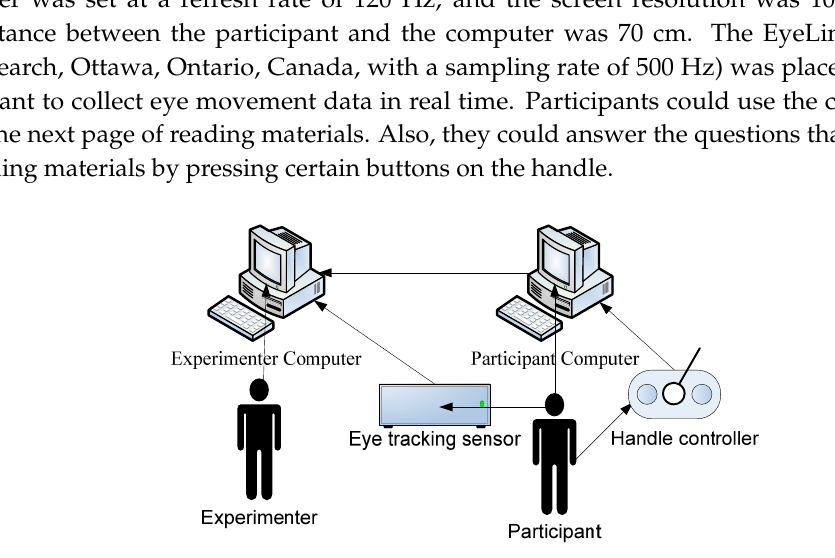
Figure 3. Experiment Setup. Note: The participant’s computer is located in front of the experimenter’s computer, thus the experimenter can observe the participant’s behavior when doing the experiments. The eye-tracking sensor is an Eyelink II helmet that is worn on the participant’s head. A handle controller is placed in front of the participant, for inputting answers to the test.